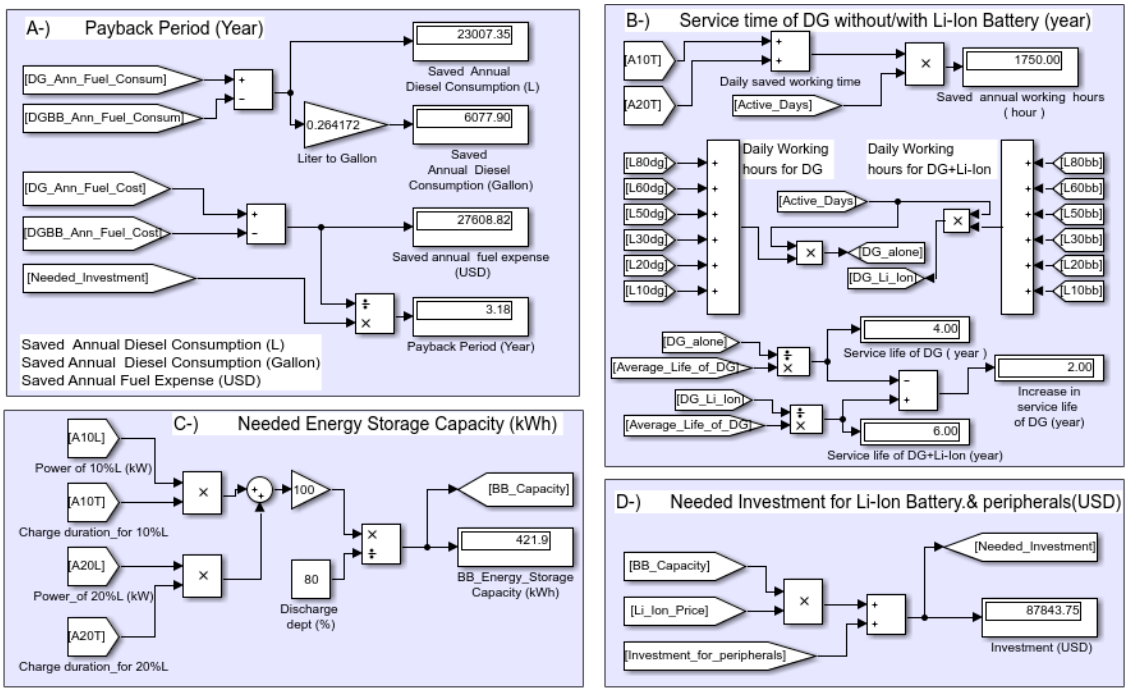
Figure 8. Comparisons and outputs block.